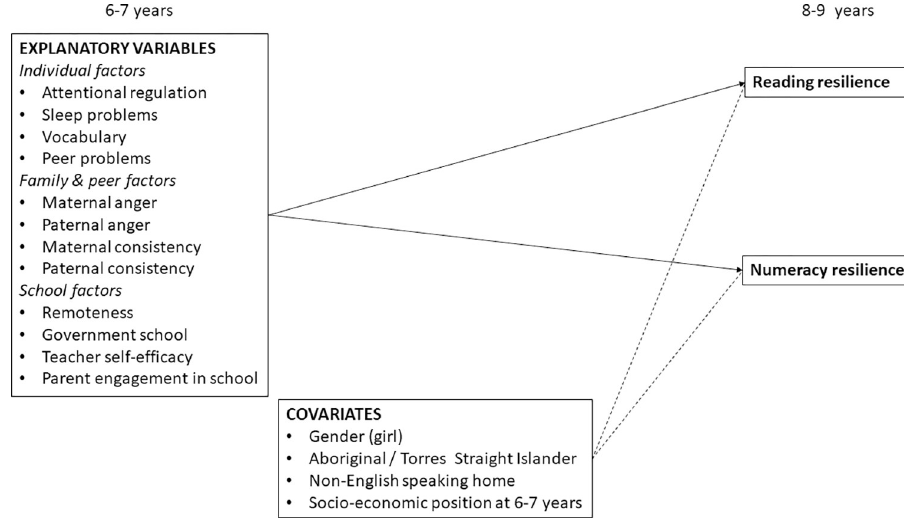
Fig 4. Final model examining association between explanatory variables at age 6–7 years and membership of academic resilience groups in each achievement domain at Grade 3 (age 8–9